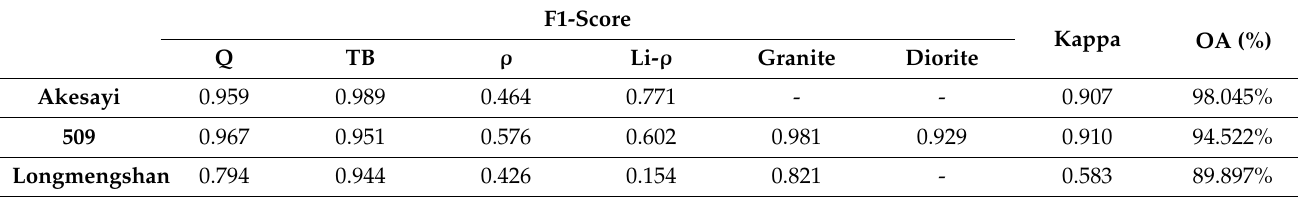
Table 3. Comparison of the different evaluation measures for RF classifiers. F1-Score